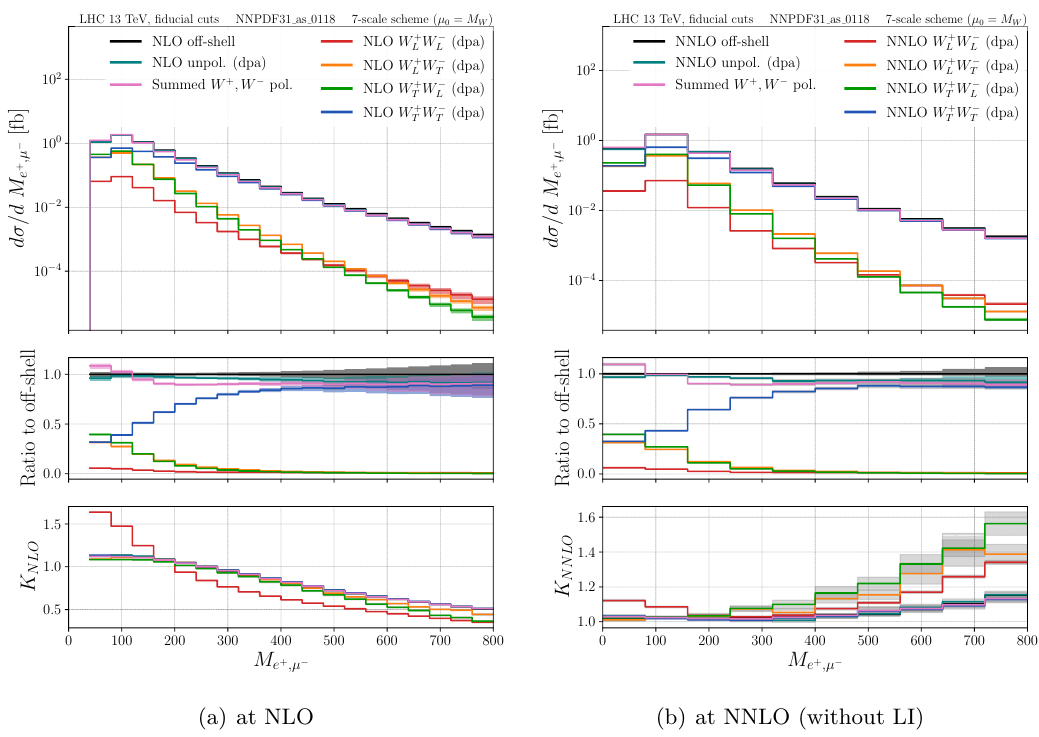
Figure 2 . Distribution of charged lepton pair invariant mass at different orders of QCD. Doubly- polarised setups are shown. From top-down: absolute value differential distribution, ratio to off-shell result, K-factor of the corresponding order. Monte-Carlo errors are shown in the middle and lower panes as grey bands. Scale variation bands are shown as coloured bands in the upper